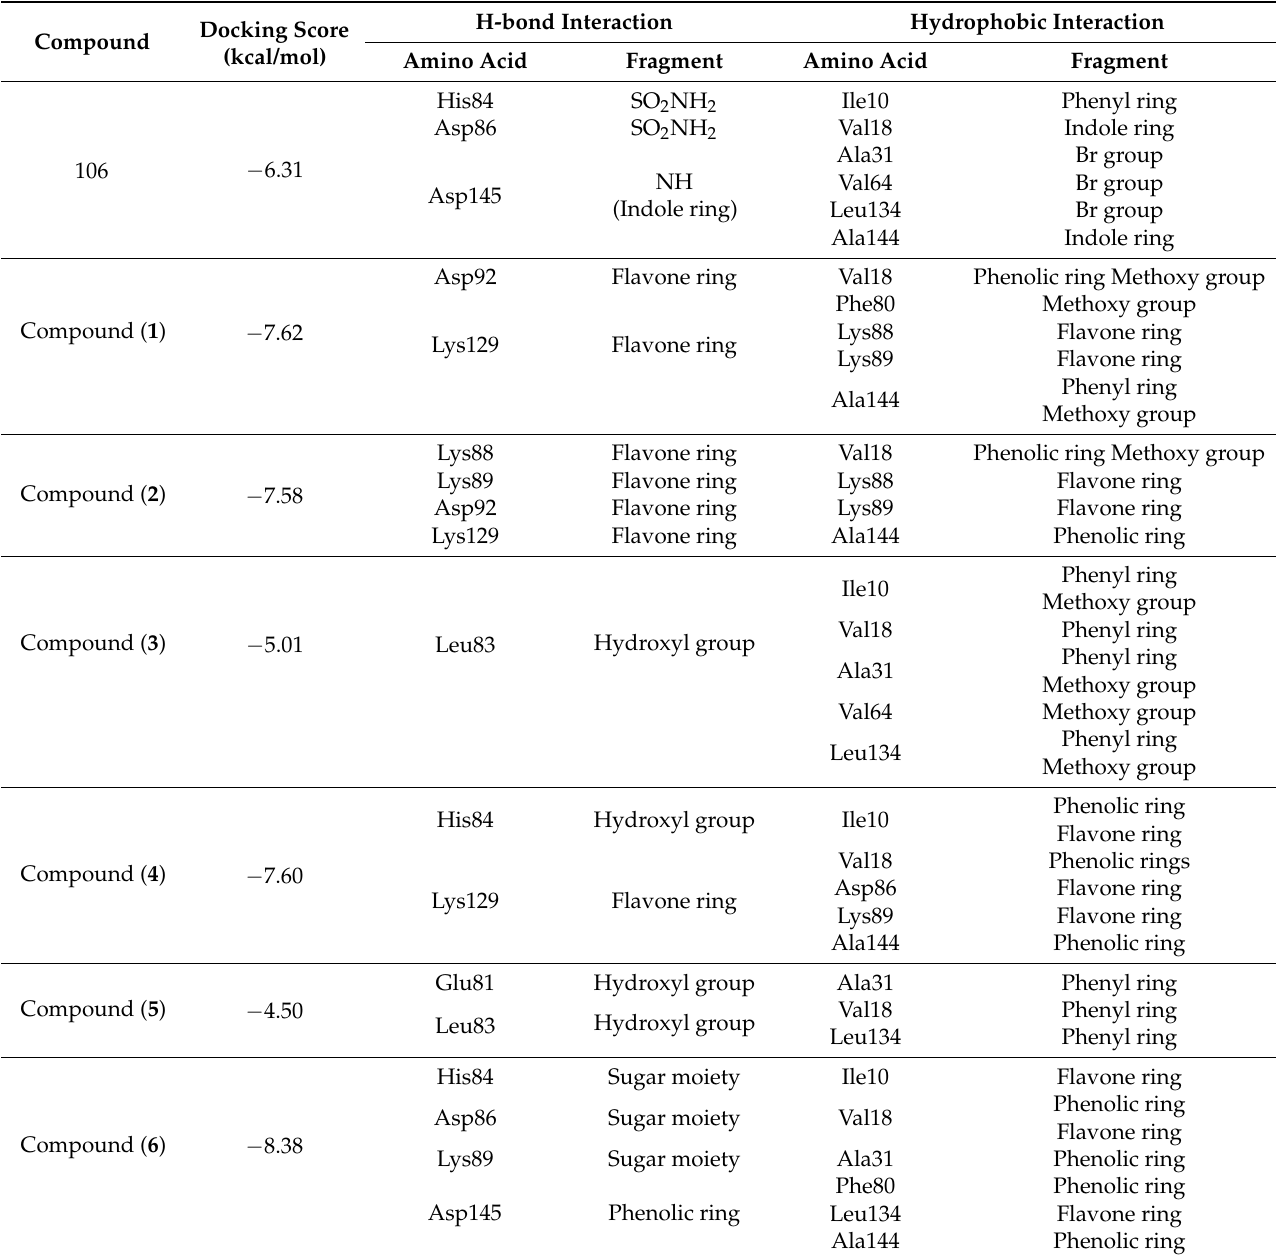
Table 2. Docking results, binding modes and interactions of pure compounds isolated from